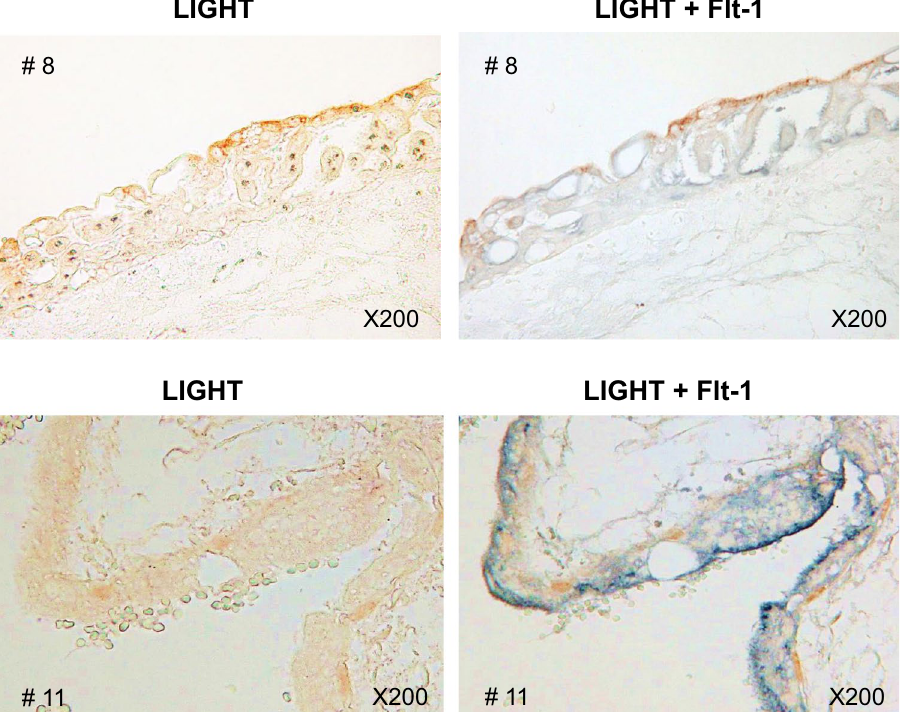
Figure 3. Co-localized expression of LIGHT and Flt-1/sFlt-1 in molar placentas. Expression of LIGHT and Flt-1/sFlt-1 were sequentially detected using anti-LIGHT antibody visualized with diaminobenzidine (brown),